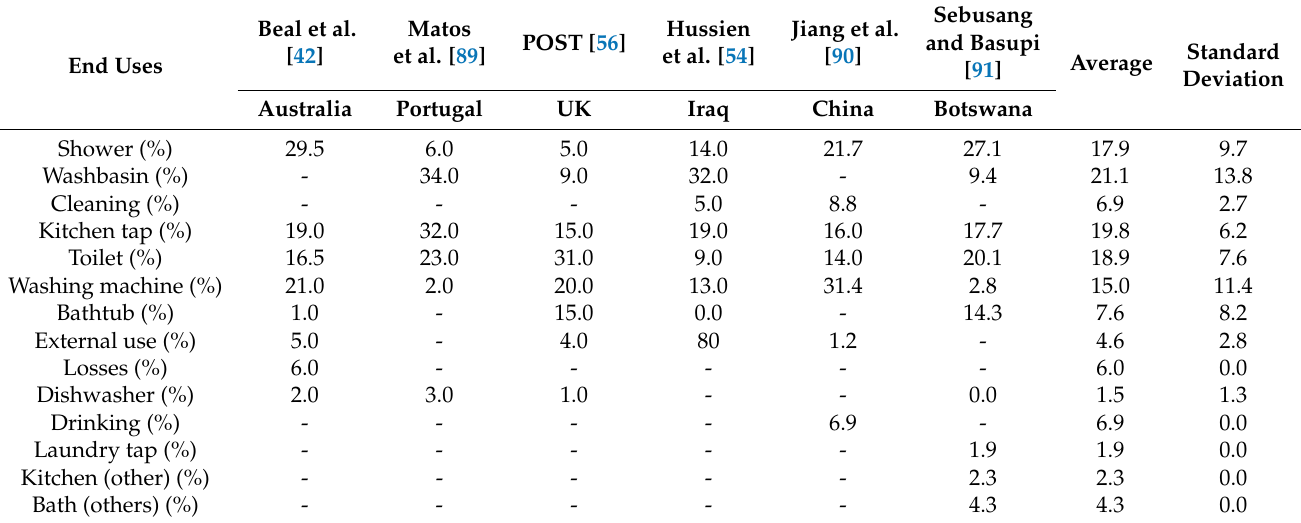
Table 5. Case studies on water end uses in residential buildings in different